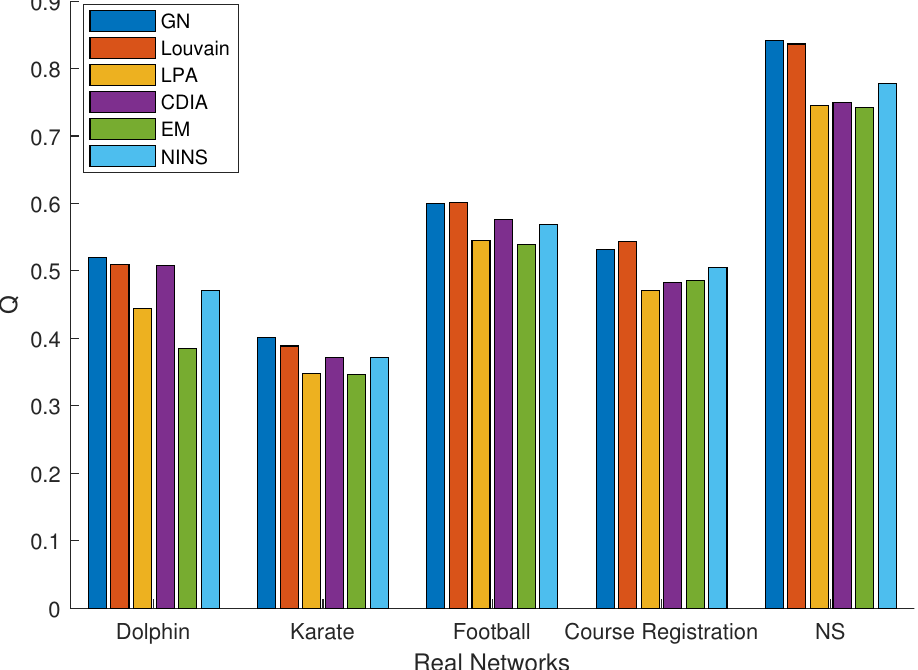
Figure 6. The modularity of NINS and five classic algorithms in five real networks.